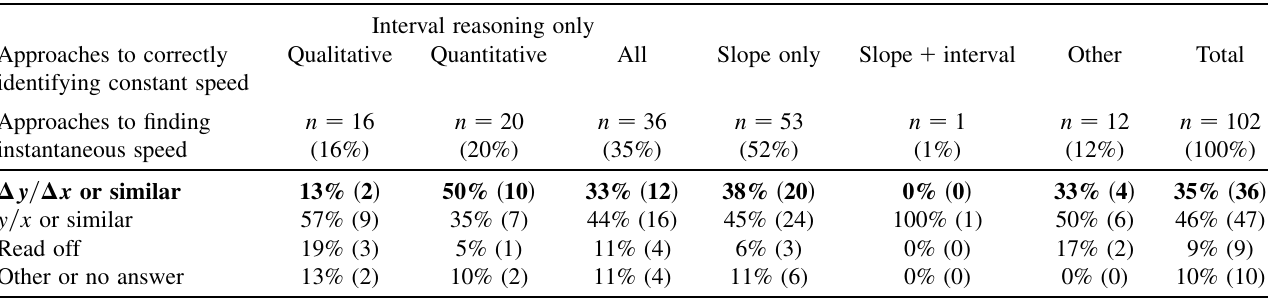
TABLE IV. Pretest results linking the reasons students gave for correctly identifying constant speed with how they determined a value for the rate of change at one particular instant. Shown here are results only for the students who answer the questions on y; x graph, direction and constancy of motion correctly. For an example of how to read the table, see the caption of Table II. Interval reasoning only Approaches to correctly